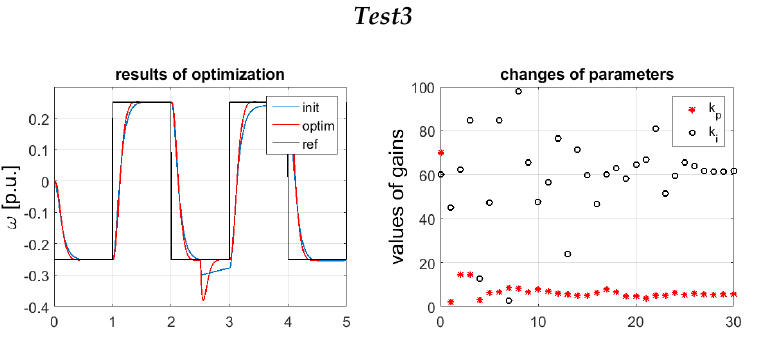
Figure 5. Results of the controller parameter optimization—influence of the initial value selection.